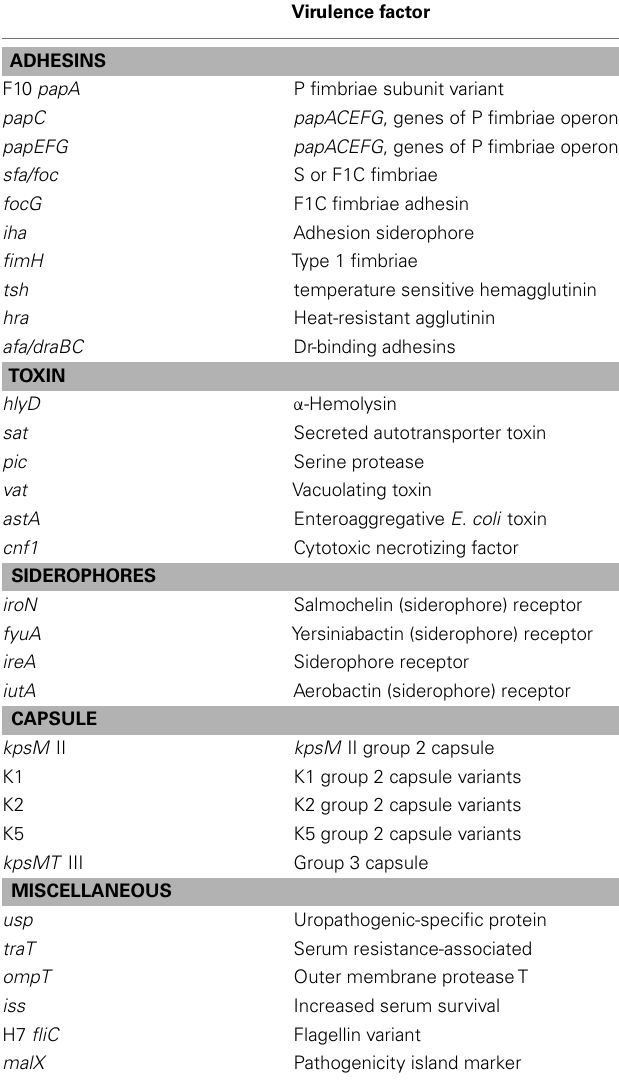
Table 1 |Virulence-associated factors present in